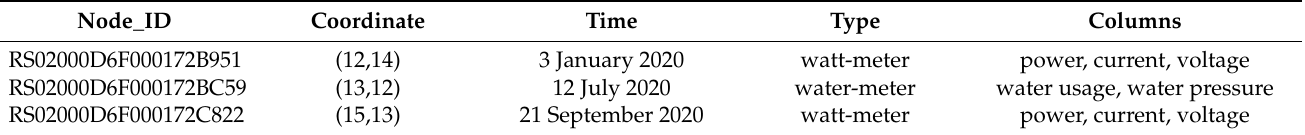
Table 1. An instance sample of